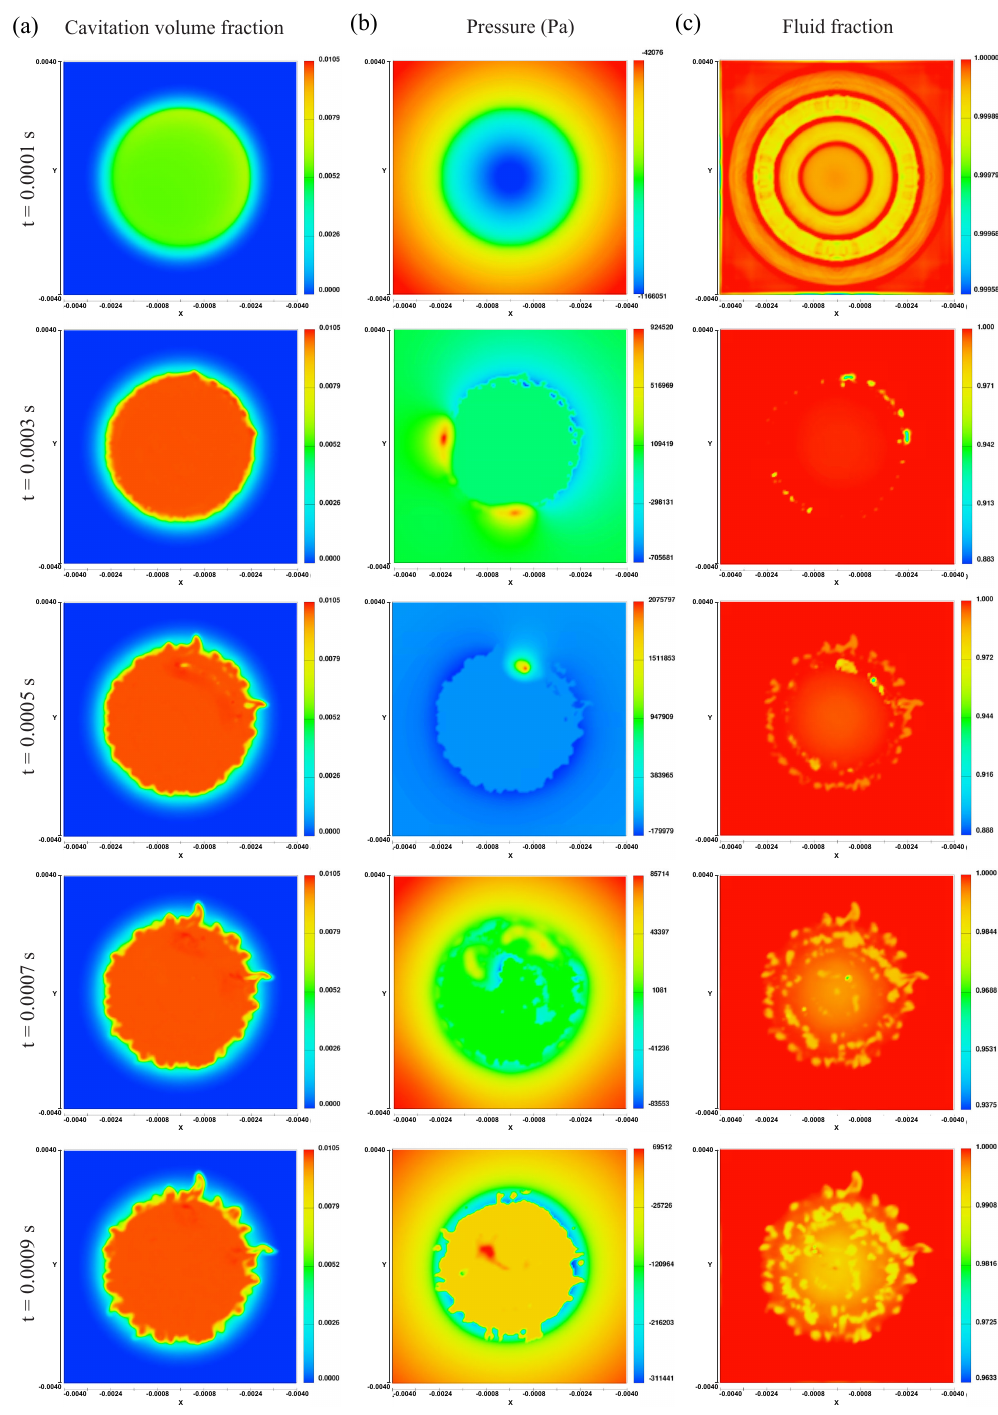
Figure 3. Development of the cavitation zone on the radiator’s surface at different times: ( a ) cavitation volume fraction, ( b ) pressure and ( c ) fluid